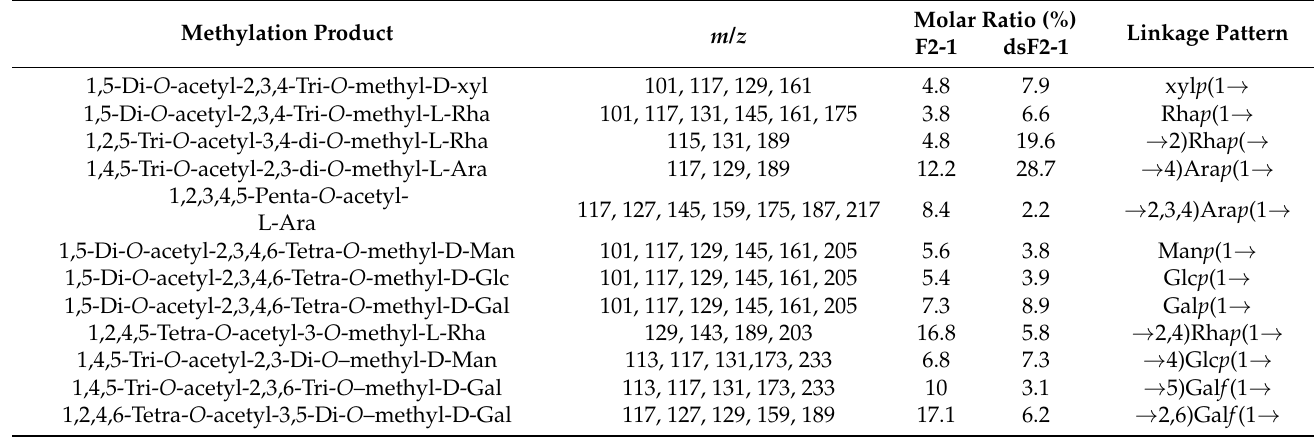
Table 1. GC–MS data analysis of partial O -methylated alditol acetates of